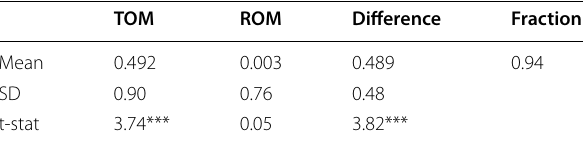
Table 4 T-test of means for “Turn-of-the-Month-Effect” of year 2014